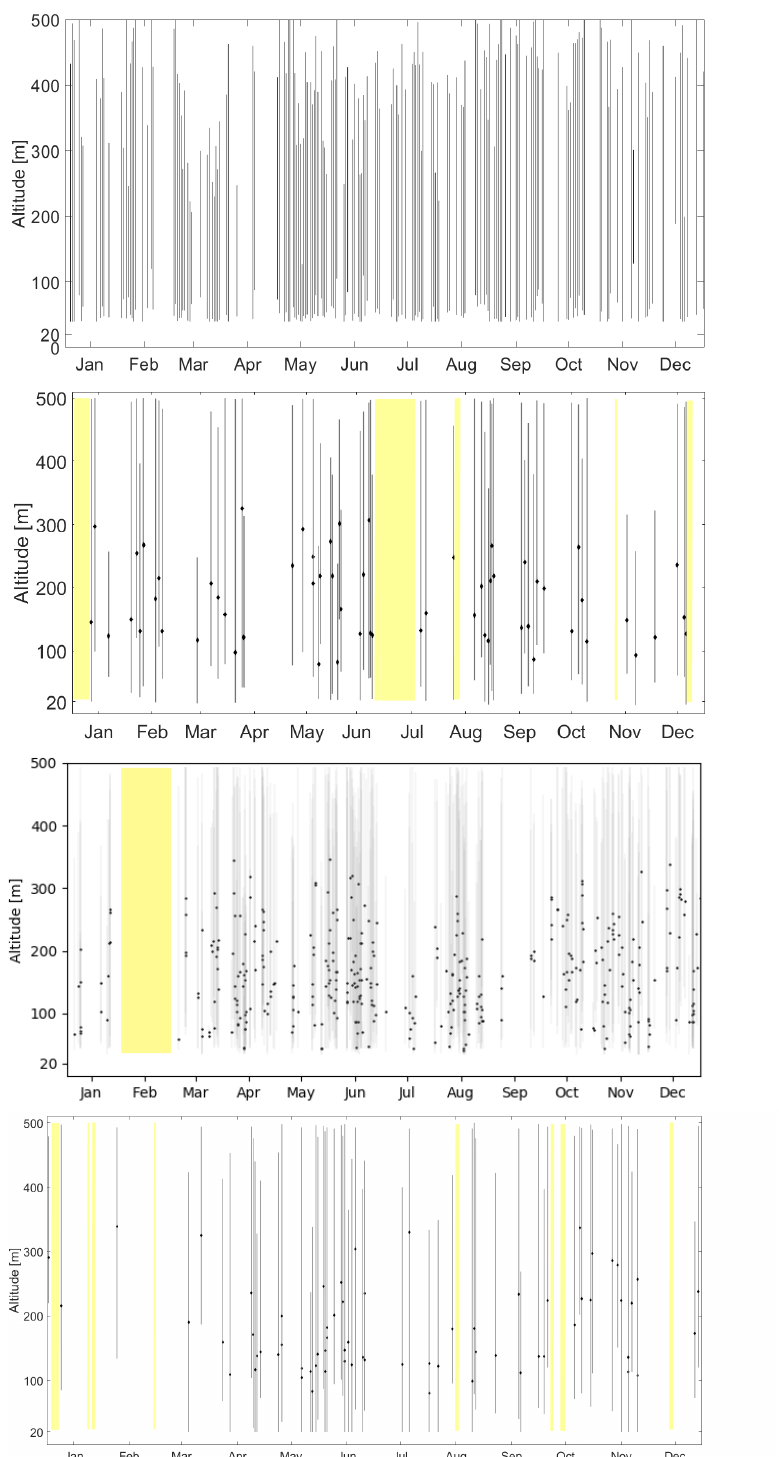
Figure 5. Occurrence and altitude distribution of the LLJ events averaged over each day that were observed by wind lidar at Heligoland from 24 March 2017 to 23 March 2018 ( first figure ), and